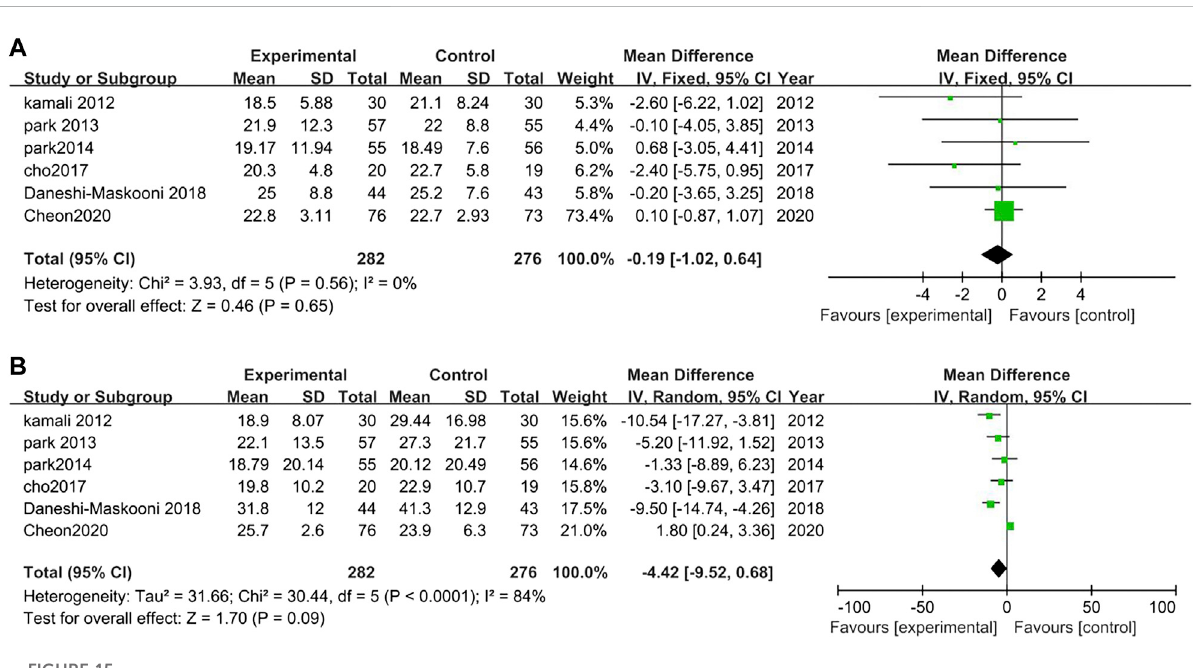
FIGURE 15 Forest plot for safety. Comparison: TCM treatment vs. placeo or blank control. (A) Forest plot of AST. (B) Forest plot of